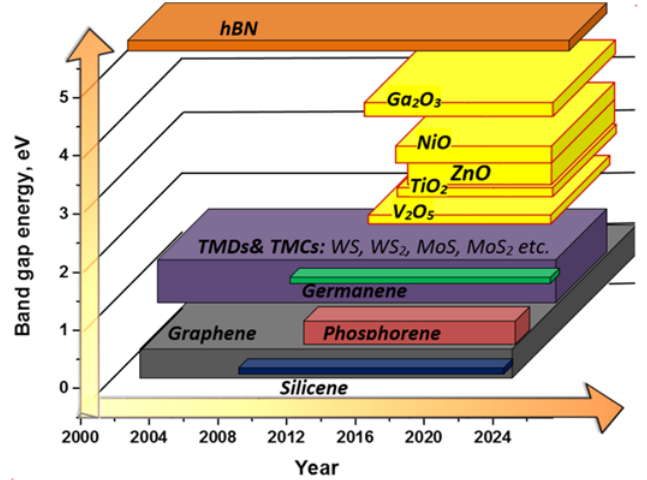
Figure 2. Illustration of the evolution of the family of 2D materials as a function of time (horizontal axis) and their respective band gap values (vertical axis). The yellow components represent the expected 2D metal oxides contribution.